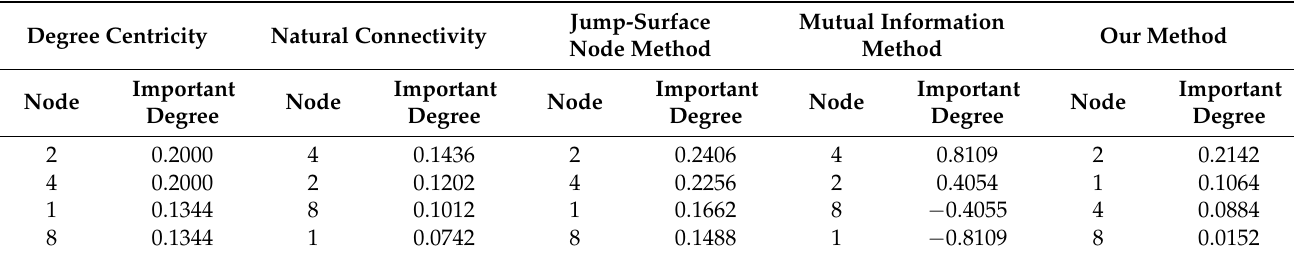
Table 3. Evaluation results of node importance in Figure